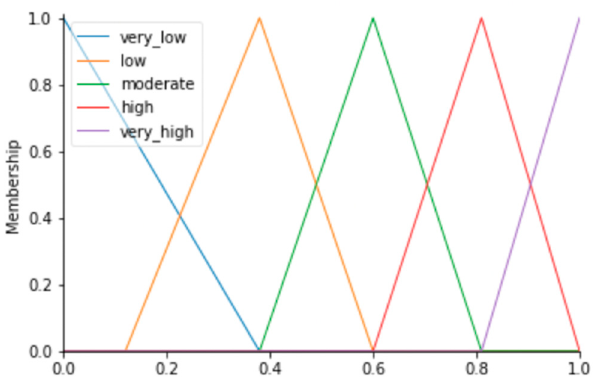
Figure 8. Membership functions for building